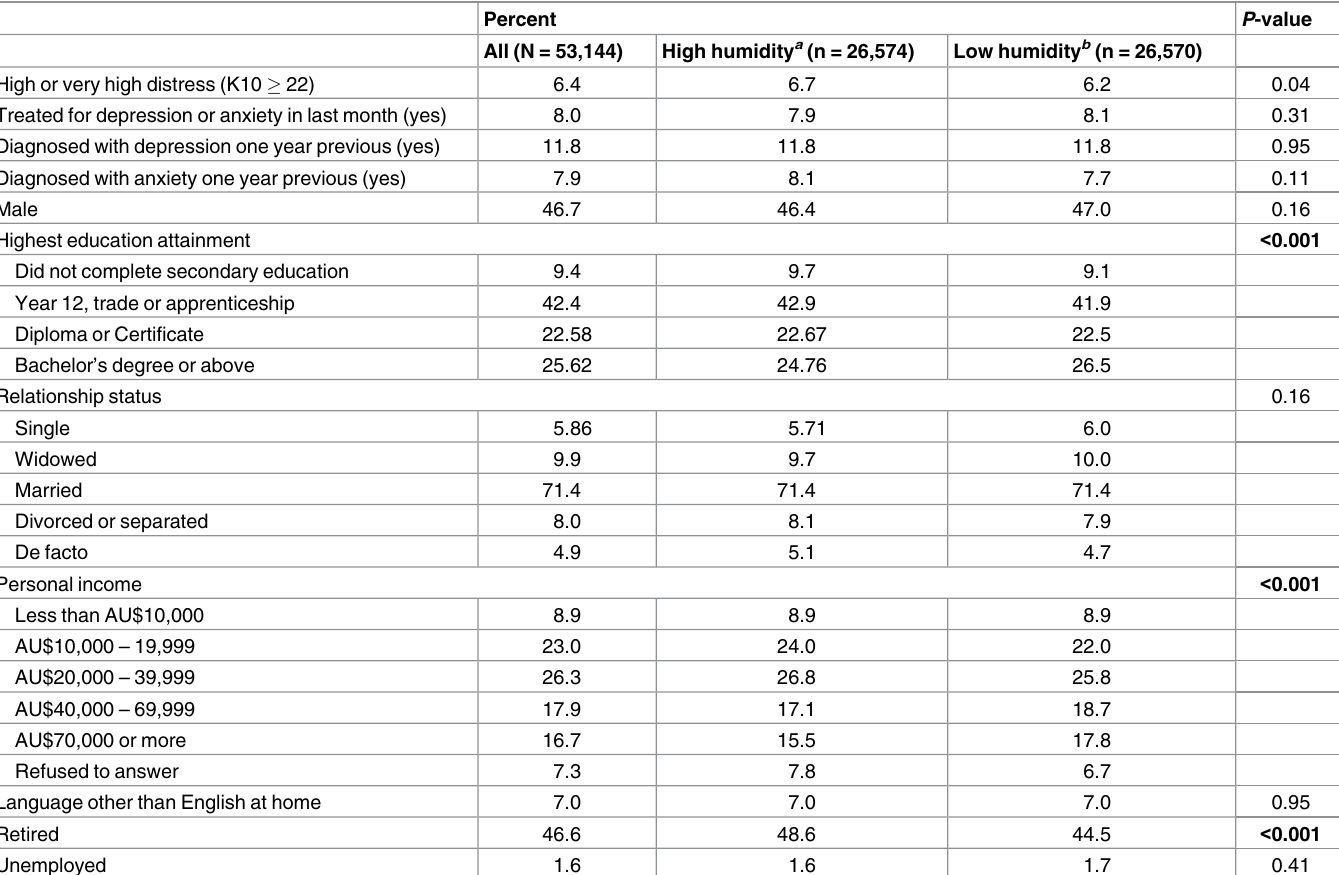
Table 1. Proportions of respondents by socio-demographic characteristics and humidity